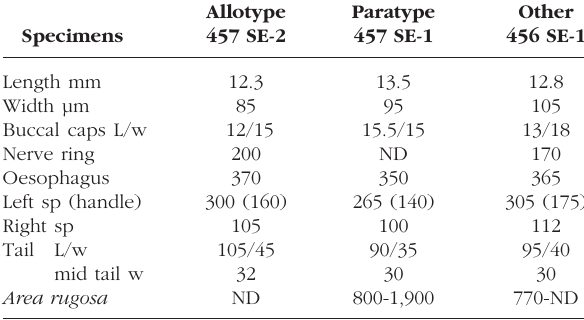
Table II. – Litomosa goodmani n. sp.; measurements of